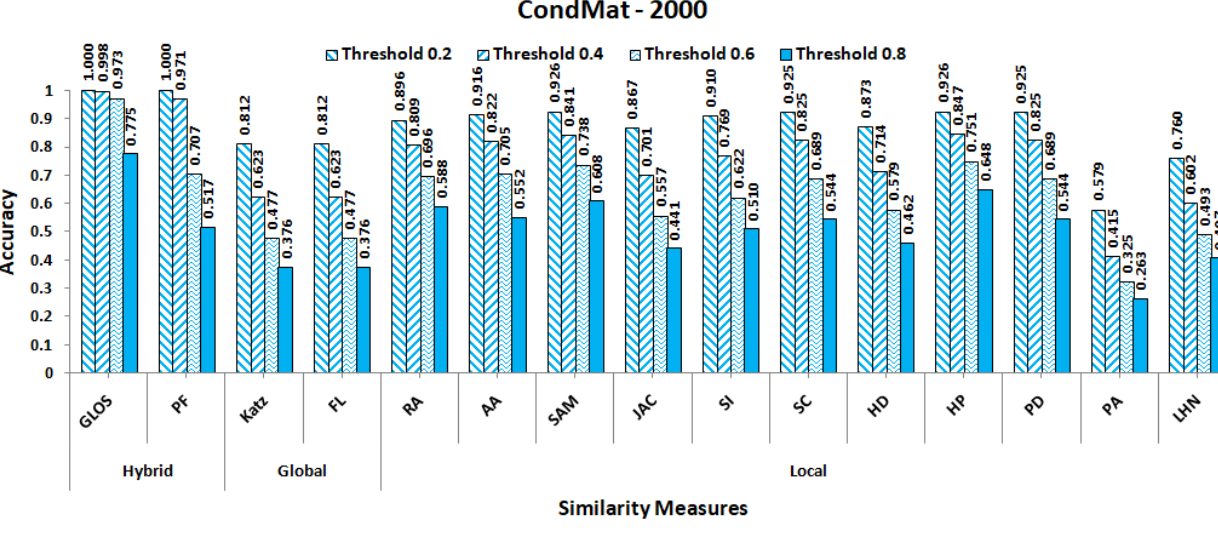
Figure 12. Comparisons of similarity measures on CondMat-2000 edge list from CondMat